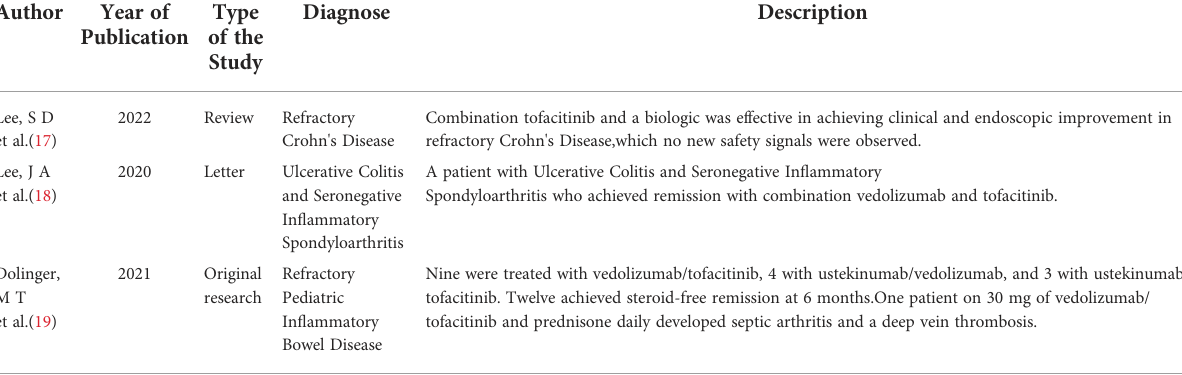
TABLE 1 Reported cases of Tofacitinib combined with Biologic